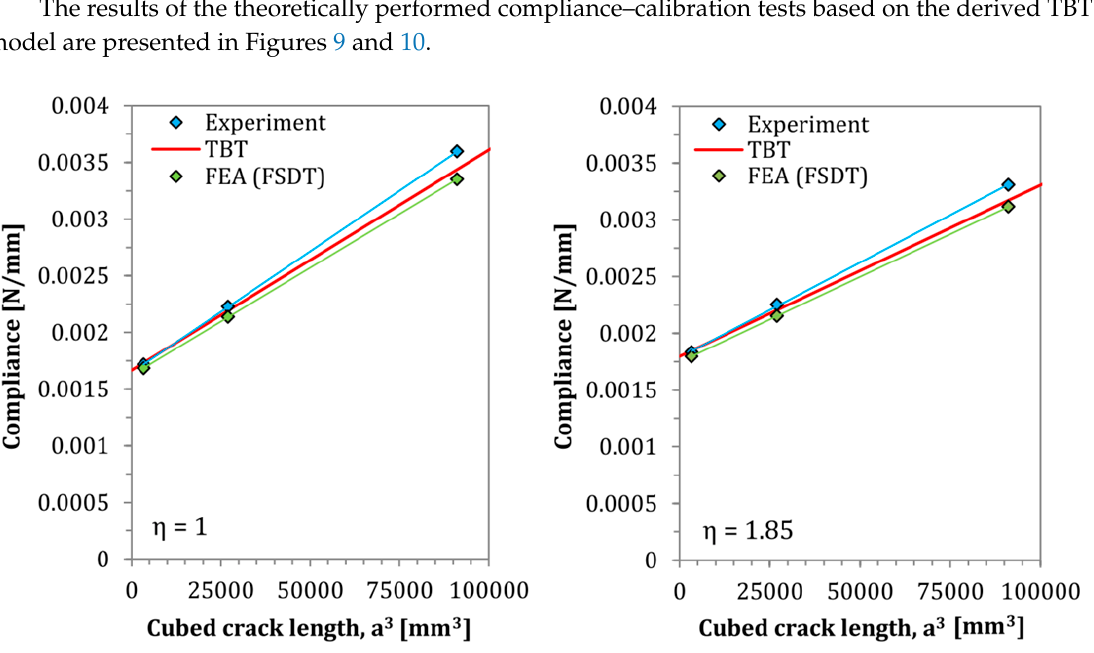
Figure 9. Predicted and tested compliances of homogeneous laminates η = 1 and η = 1.85.